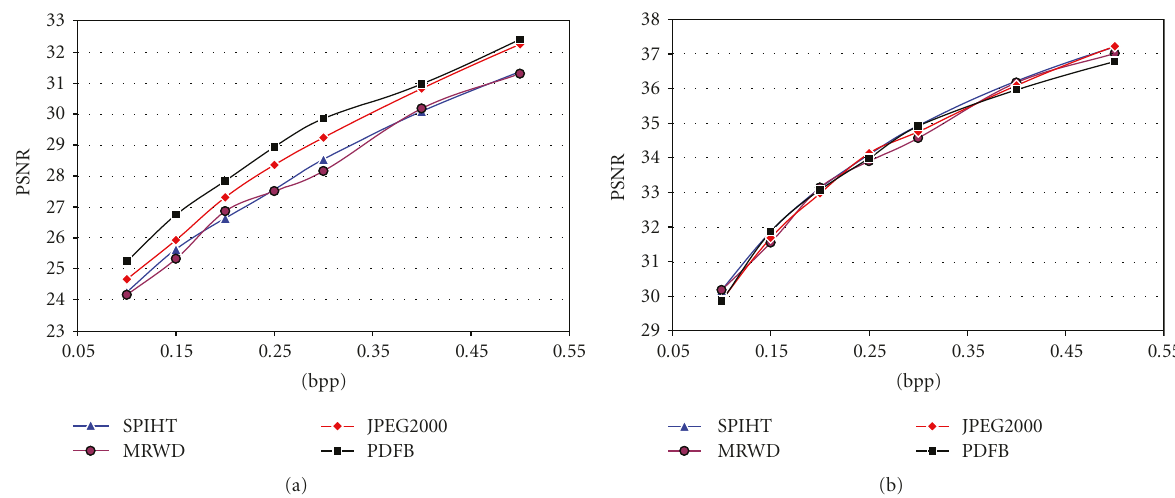
Figure 22: Comparison of rate-distortion curves using SPIHT, MRWD, JPEG2000, and the proposed PDFB-based codec: (a) Barbara, (b)